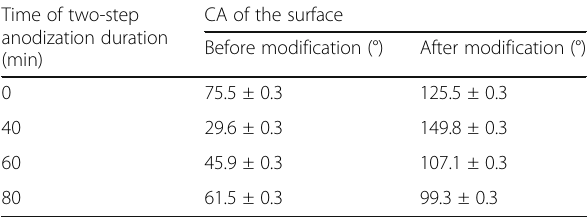
Table 1 Water contact angle of the ZnO films prepared on PAA with different times of two-step anodization duration Time of two-step anodization